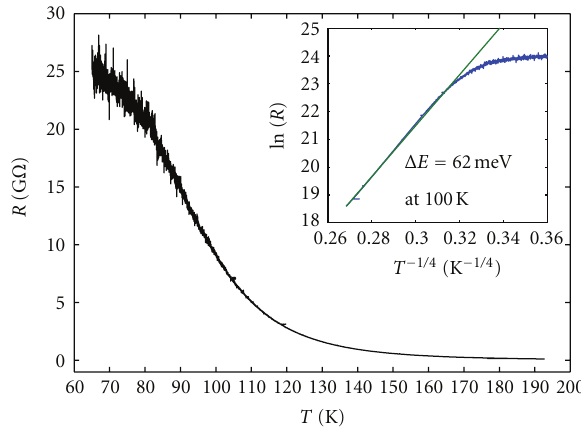
Figure 2: Ga 0 . 95 Mn 0 . 05 As nanowire resistance as a function of temperature. The inset shows a plot of ln( R ) versus T − 1 / 4 , with the extracted activation energy of 62meV at